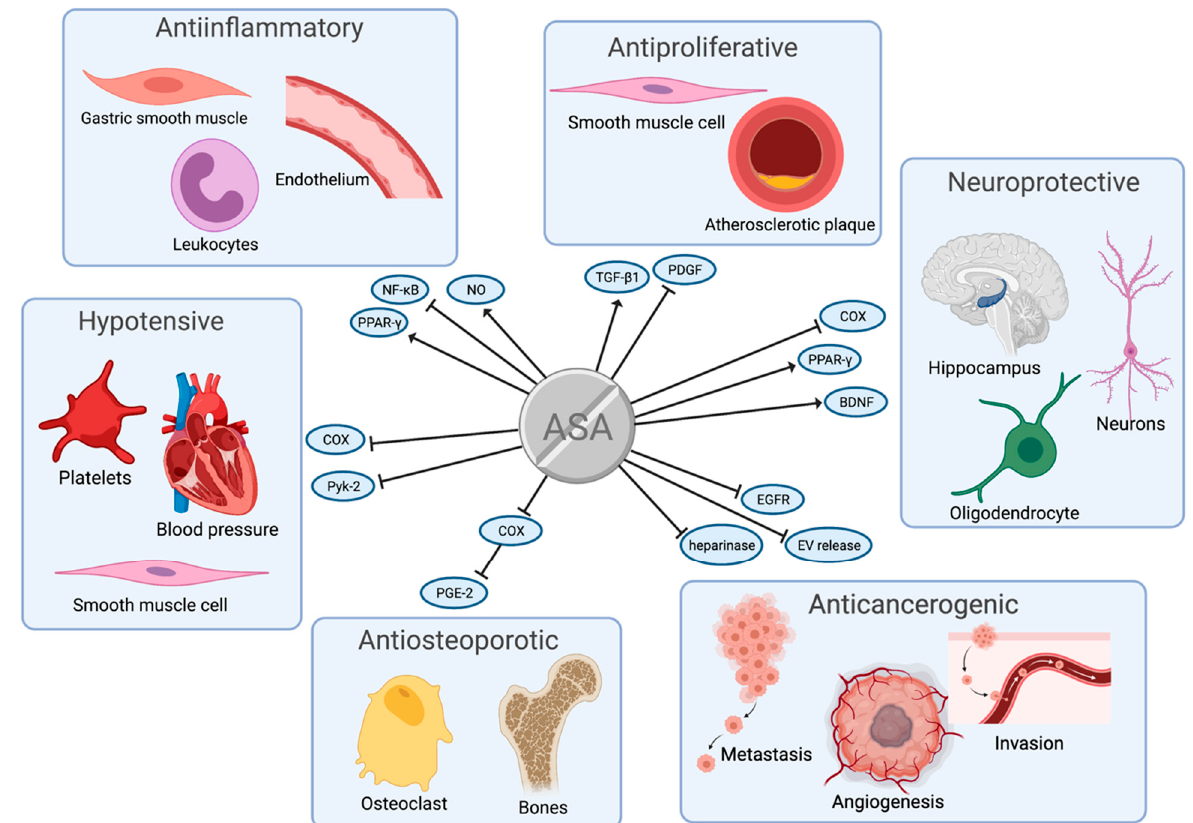
Figure 2. Pleiotropic effects of acetylsalicylic acid (ASA) discussed in this review. For details regarding the mechanisms, please see the main text. BDNF—brain-derived neurotrophic factor; COX—cyclooxygenase; EGFR—epidermal growth factor receptor; EV—extracellular vesicles; NF- κ B—nuclear factor kappa-light-chain-enhancer of activated B cells; NO— nitric oxide; PDGF—platelet-derived growth factor; PGE-2—prostaglandin E-2; PPAR γ —peroxisome proliferator-activated receptor gamma; Pyk-2—proline-rich tyrosine kinase 2; TGF- β 1- transforming growth factor β 1. Figure created with BioRender.com.